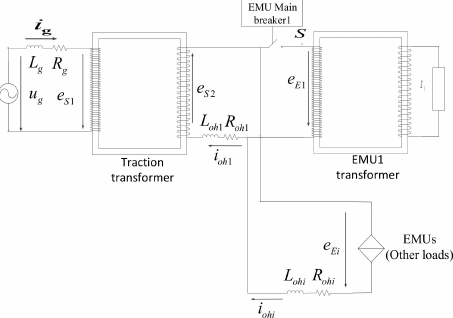
Figure 2. Simplified circuit of the traction supply system.